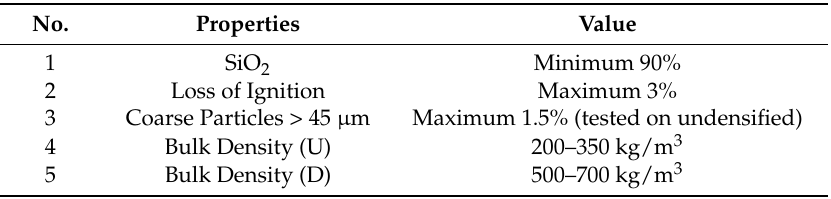
Table 1. Chemical and Physical Properties of Undensified Silica Fume